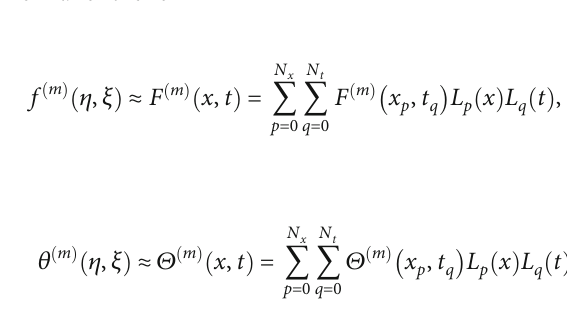
: 8, ξ = 1, N N Df = Sr = Bi = 0 : 5, He = δ b = t = w = 0